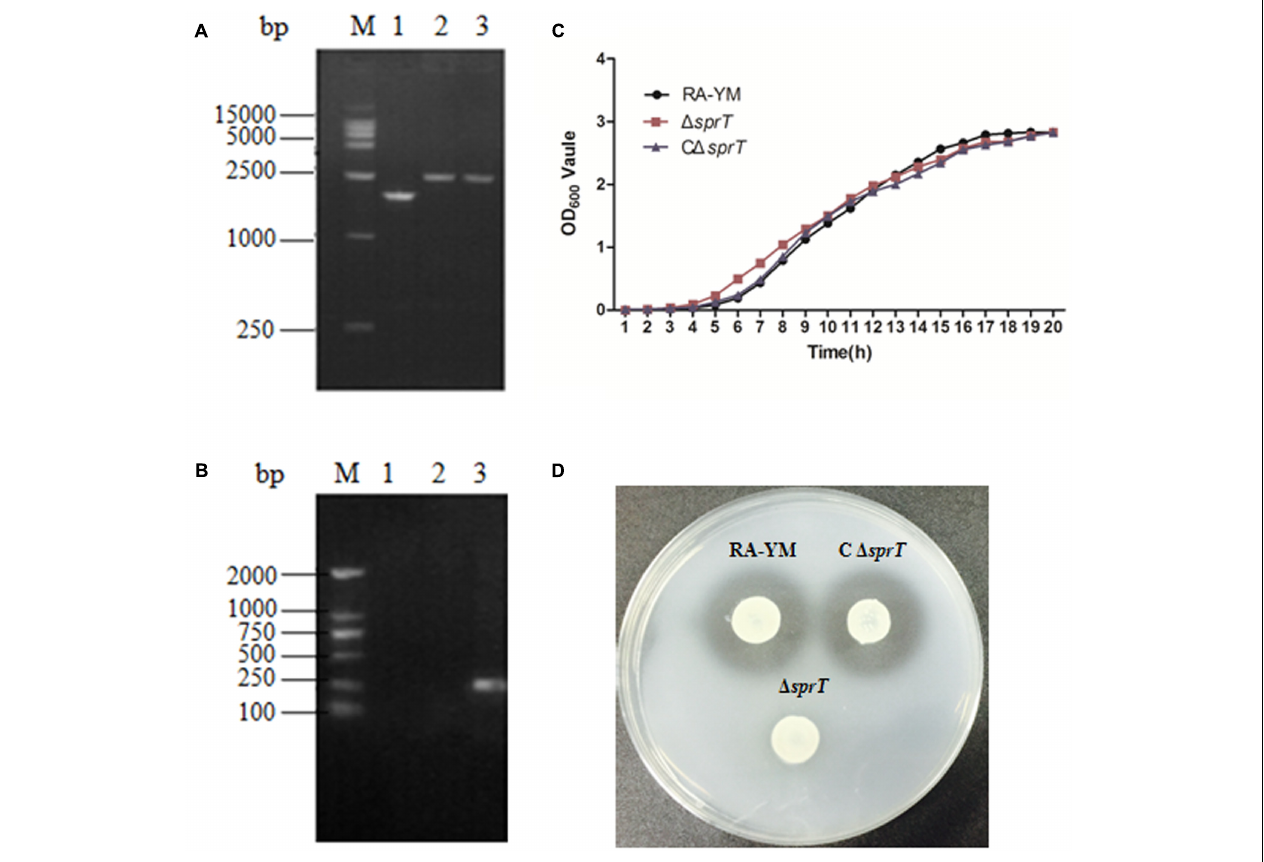
FIGURE 1 | Identification and characterization of mutant strain (cid:49) sprT and complemented strain C (cid:49) sprT . (A) PCR amplification of mutant strain (cid:49) sprT and wild-type strain RA-YM using primers SprT-F1 and SprT-R2. Lane M: DL2000 DNA marker; lane 1: Leftarm-Rightarm DNA fragment (1752-bp) from the wild type; lane 2: Leftarm-Spc-Rightarm DNA fragment (2538-bp) from (cid:49) sprT ; lane 3: pRE-LSR (positive control; 2538-bp). (B) PCR amplification of the deleted part of the sprT gene using primers SprT-IS and SprT-IR. Lane M: DL2000 DNA marker; lane 1: pRE-LSR (positive control) no fragment was amplified; lane 2: (cid:49) sprT —no fragment was amplified; lane 3: RA-YM (300-bp). (C) Growth curves for RA-YM, (cid:49) sprT and C (cid:49) sprT . (D) Liquefied gelatin following cultivation of RA-YM, (cid:49) sprT, and C (cid:49) sprT on a nutrient gelatin